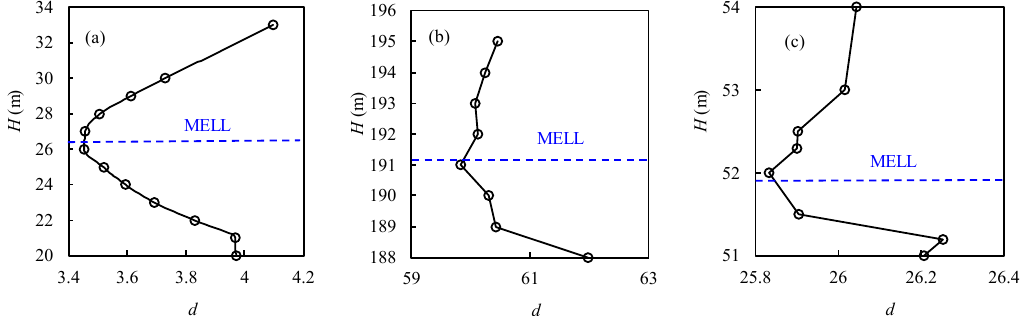
Figure 3. Water level ( H )-evaluation function ( d ) curves for ( a ) the Dongting Lake, ( b ) the Ebinur Lake, and ( c ) the Honghe wetland.